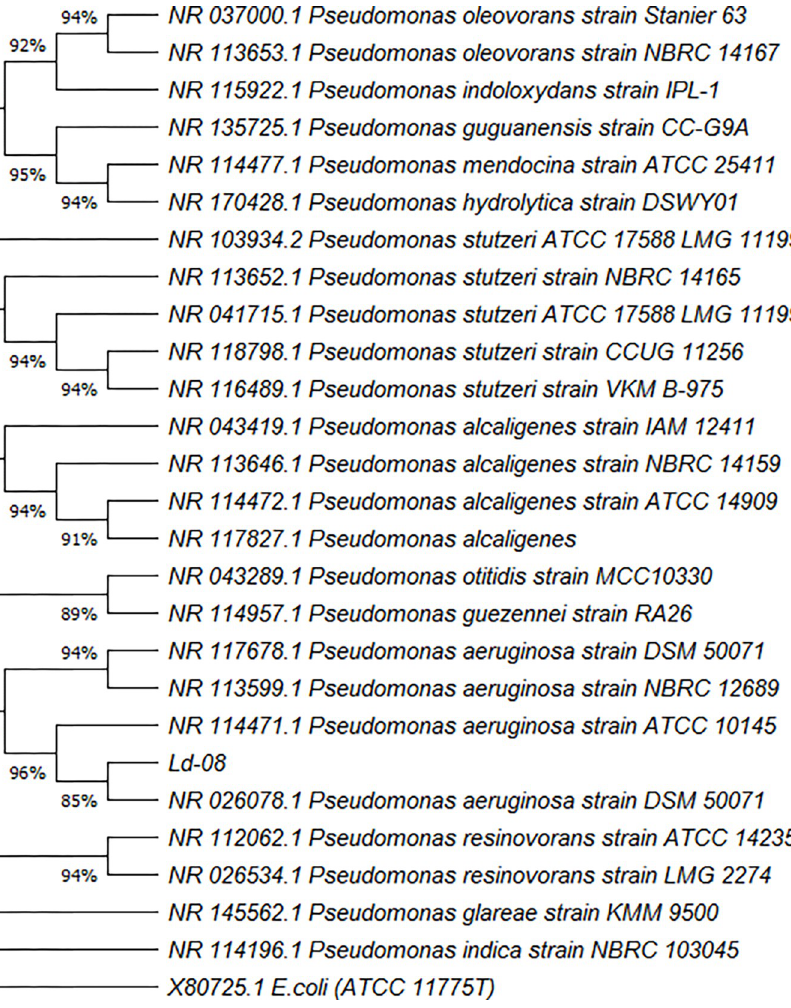
Fig 2. Maximum-likelihood phylogenetic tree based on the 16S rRNA gene sequences of strain Ld-08 and related strains in the genus Pseudomonas . Bootstrap values are shown as percentages of 1000 replicates. The E . coli strain ATCC 11775T was used as an out-group. Evolutionary analysis were conducted in MEGA X